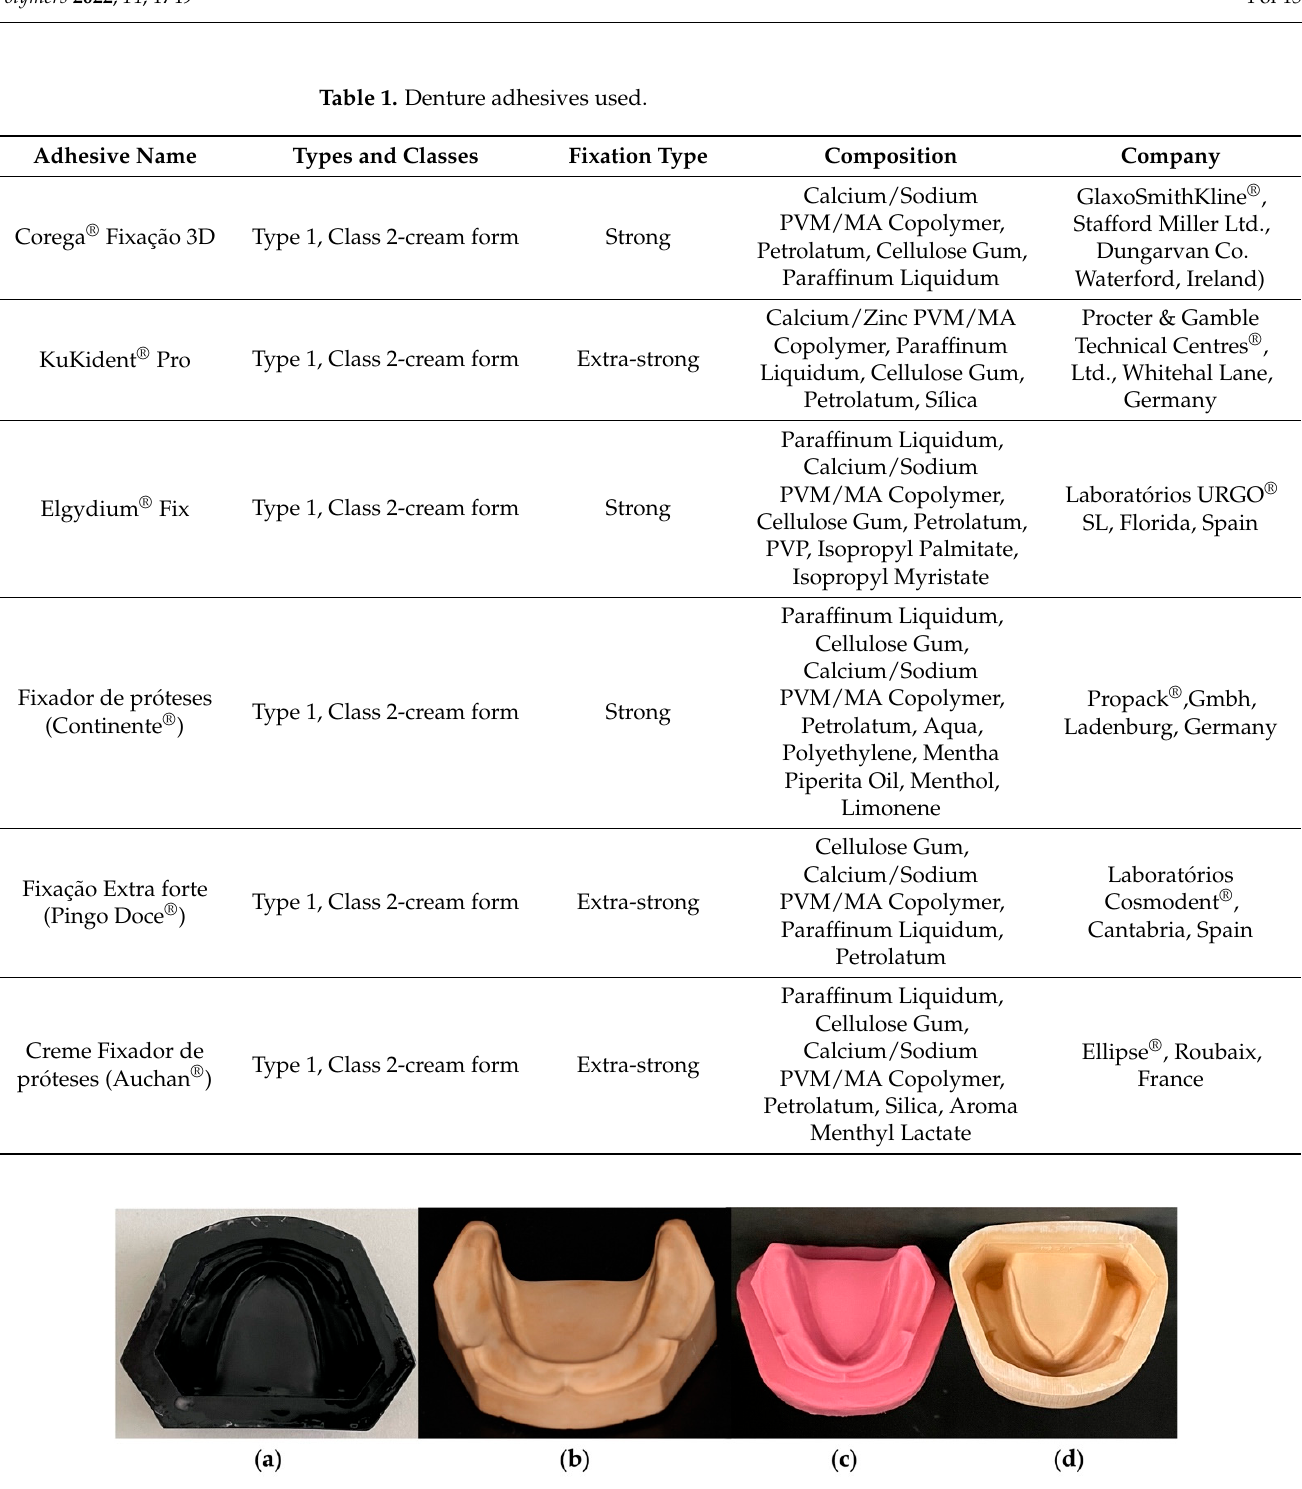
Figure 1. Elaboration of the work model. ( a ) Plaster model mold (Edentulous Jaw); ( b ) Duplication of the plaster model mold; ( c ) Positive mold of the silicone work; ( d ) Negative plaster mold of the original model.